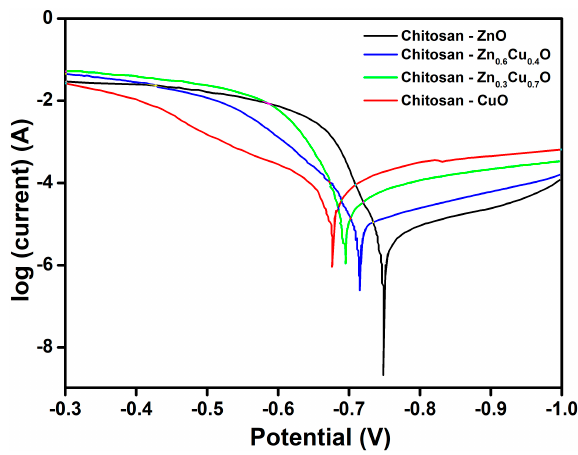
Figure 6. Tafel polarization curves for electrosynthesized composite thin films.